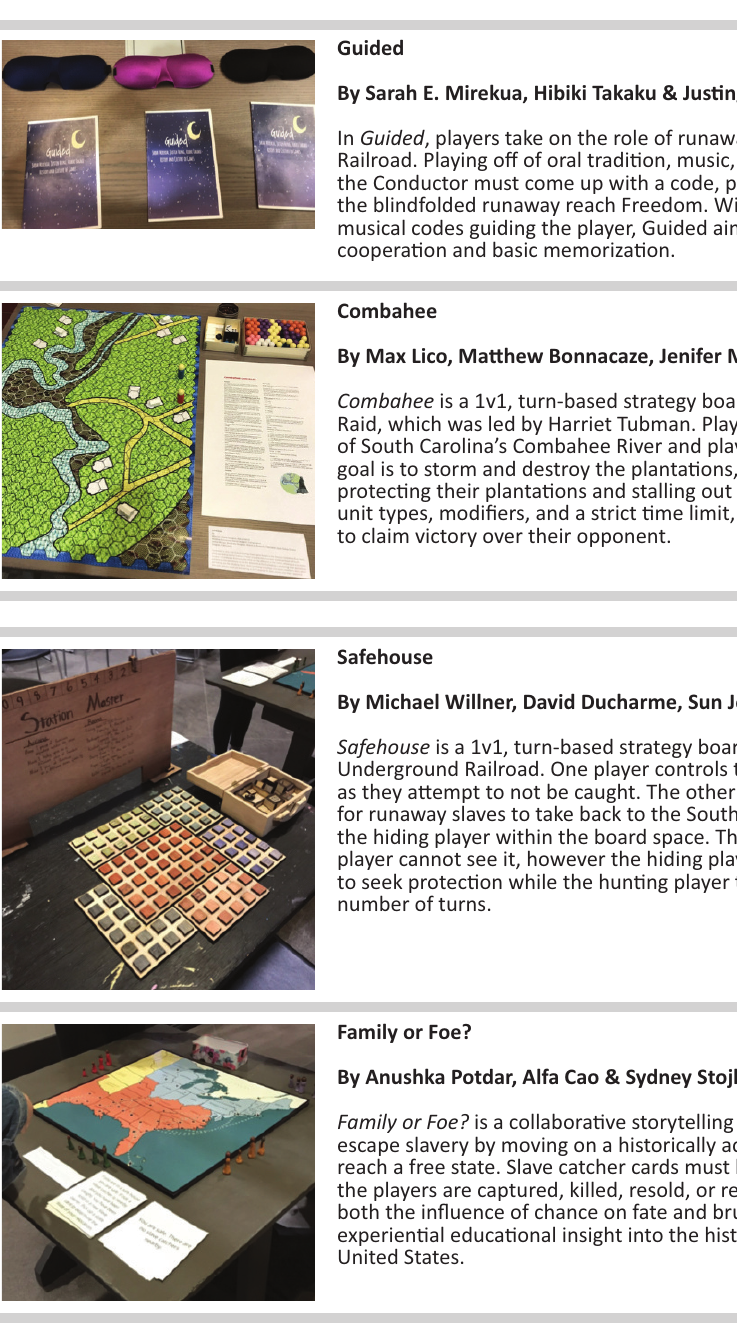
Figure 2. Images and descriptions of the four student games selected for public exhibition: Guided, Combahee, Safehouse, and Family or